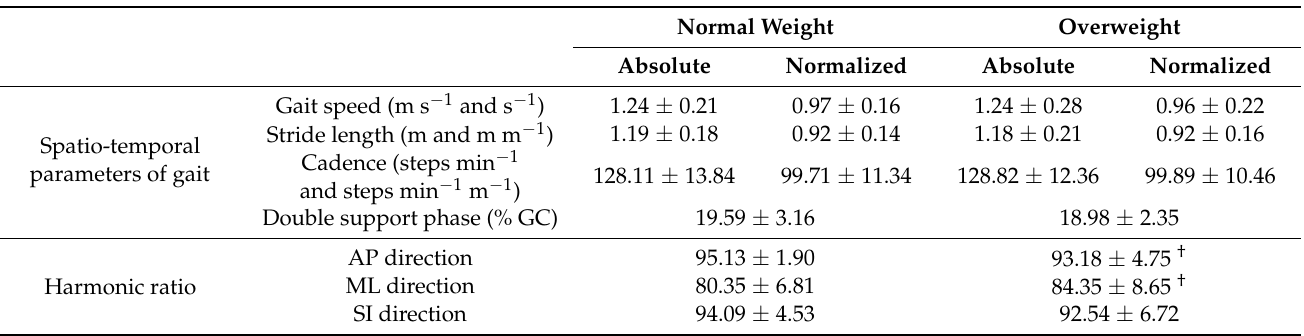
Table 2. Spatio-temporal and smoothness-of-gait parameters calculated for the two groups of children. Values are expressed as mean ± SD. Normal Weight Overweight